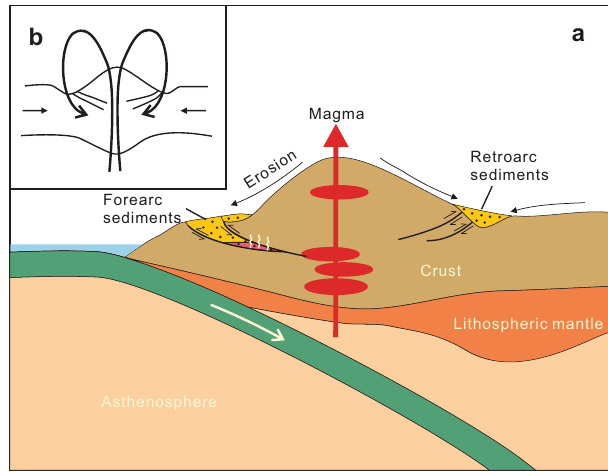
Fig. 4 Cartoon showing rapid endogenic recycling of arc magmatic rocks through thrust channels in continental arcs (not to scale). a Thrust-driven rock recycling in this study: from arc magmatism, to erosion and weathering at the surface, to forearc sedimentation, then to burial and remelting. b Sketch diagram illustrating the self-recycling process in arc